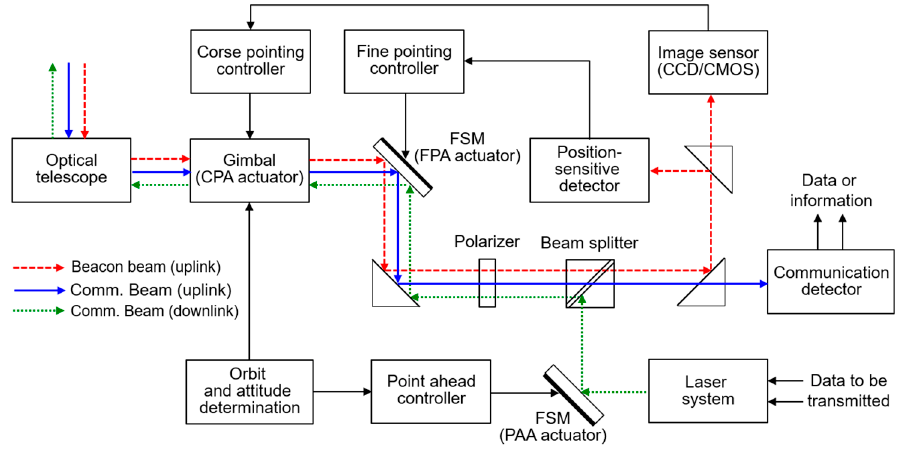
Figure 1. Block diagram of the optical communication terminal with monostatic architecture.